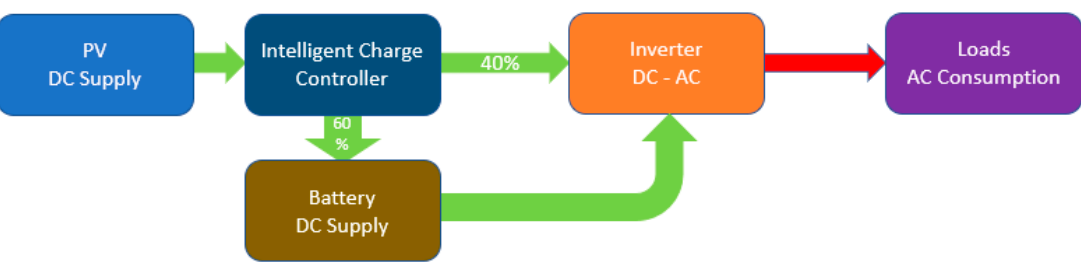
Figure 6. Our proposed model to avoid DC–AC conversion losses.